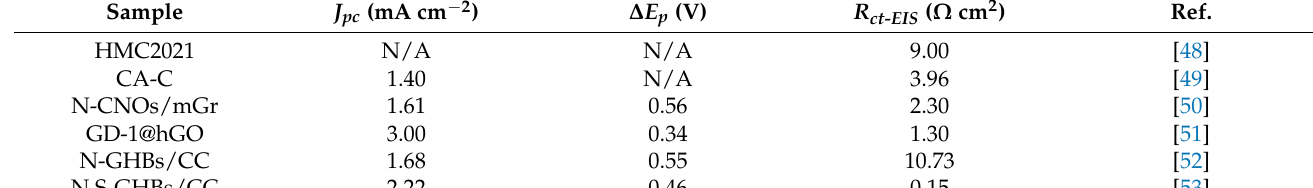
Figure 3. The SEM images of ( a ) HMC2021 [48], ( b ) CA-C [49], ( c ) N-CNOs/mGr [50], ( d ) N-GHBs (inset shows their TEM images) [52], and ( e ) N,S-GHBs [53].